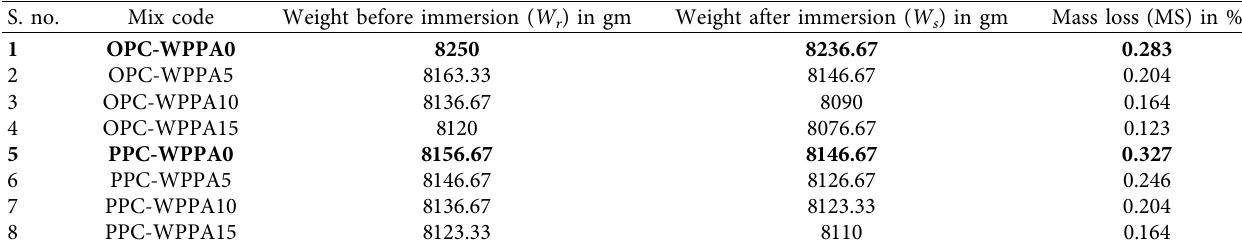
Bold shows control mix. Table 14: Mass loss of OPC-WPPA and PPC-WPPA concrete cured under 2% sulfuric acid. S.